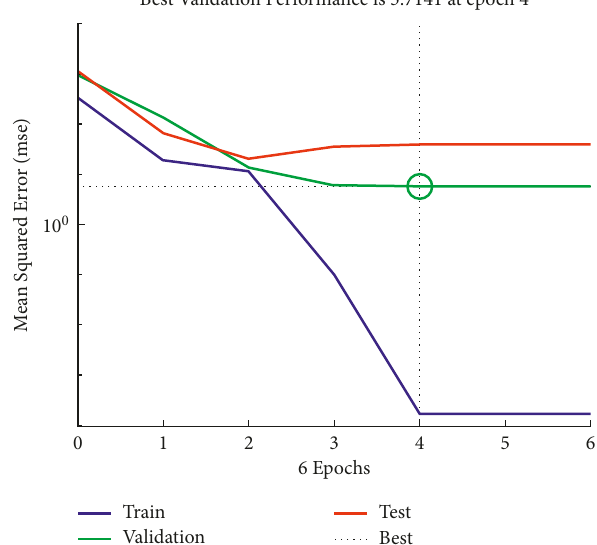
Figure 6: MSE vs. the number of epochs in the hidden layer.